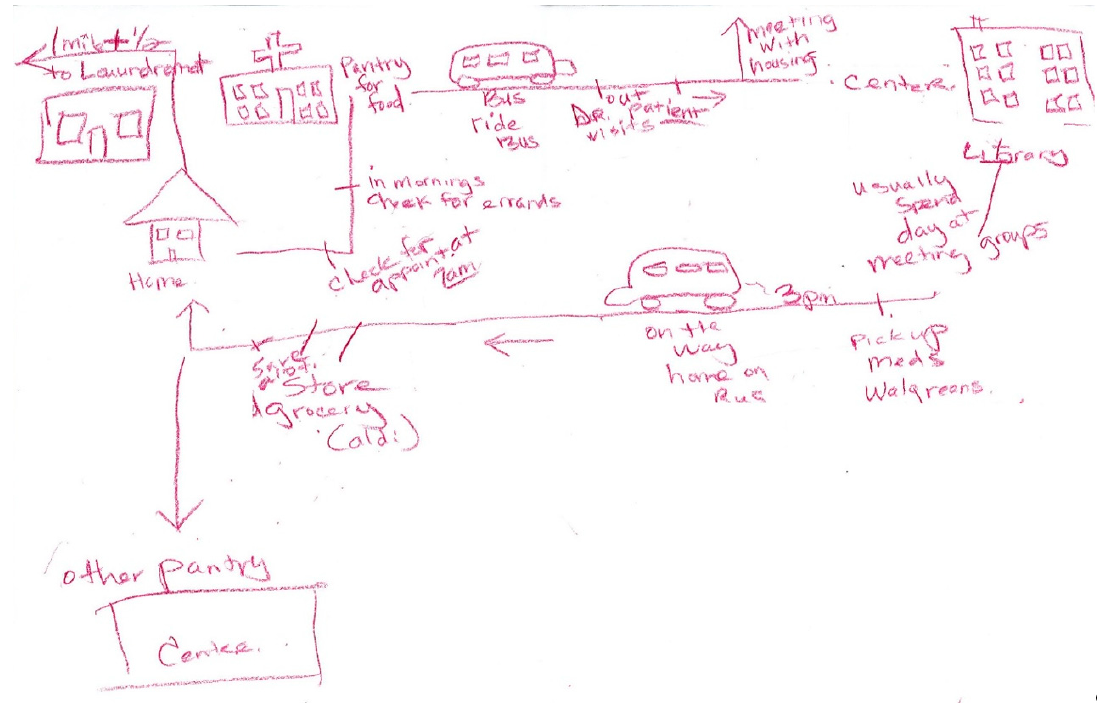
Figure 3. Debra’s map.